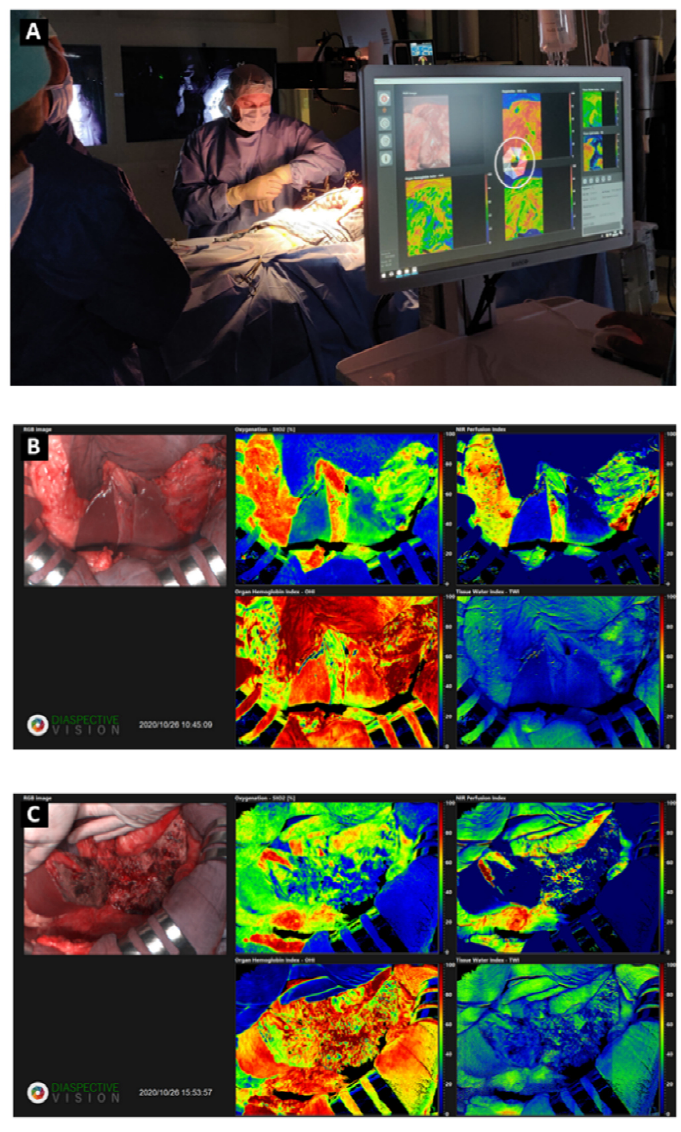
Figure 1. Intra-operative setting of HSI and acquired images. During the acquisition of data, all the lights of the operating room are turned off ( A ). The acquisition was performed at the beginning of the surgical procedure ( B ) and after the liver resection, at the end of surgery ( C ). The RGB (Red-Green-Blue) images and StO 2 %, NIR, OHI, and TWI indexes are reported.